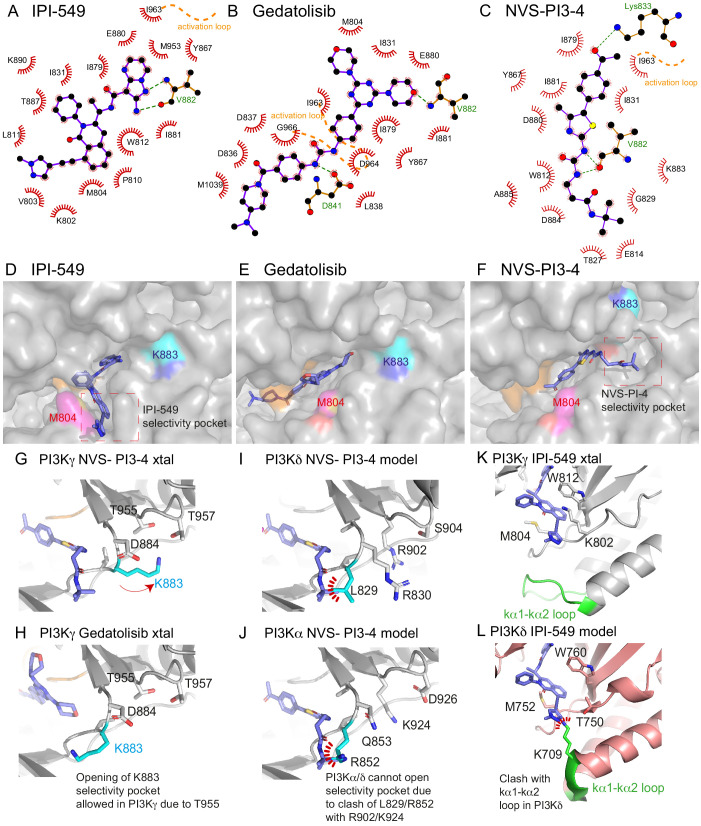
Structures of Gedatolisib, IPI-549, and NVS-PI3-4 bound to p110γ.(A–C) LigPlot+ (Laskowski and Swindells, 2011) representations of p110γ bound to (A) IPI-549, (B) Gedatolisib, and (C) NVS-PI3-4. Hydrogen bonds are shown in green. All inhibitors form hydrogen bonds (green) with V882 in the hinge. The activation loop is shown as an orange dotted line. (D–F) Comparison of Gedatolisib, IPI-549, and NVS-PI3-4 bound to p110γ with the activation loop and selectivity pockets highlighted. M804 and K883 that change conformation upon selectivity pocket opening are coloured in magenta and cyan, respectively. (G–J) Molecular basis for NVS-PI3-4 for p110γ over p110α/δ. The structure of p110γ bound to NVS-PI3-4 (G) compared to p110γ bound to Gedatolisib (H), revealed a conformational change in K883 leading to opening of pocket accommodating the t-butyl motif. Comparing this to a model of p110δ (PDB: 5DXU) (Heffron et al., 2016) (I) and p110α (PDB: 4JPS) (Furet et al., 2013) (J) with NVS-PI3-4 revealed that this pocket is unlikely to open with L829 in p110δ and R852 in p110α (corresponds to K883 in p110γ) unable to adopt this conformational change due to steric clashes / electrostatic repulsion with R902 in p110δ and K924 in p110α (corresponds to T955 in p110γ). (K–L) Molecular basis for IPI-549 specificity for p110γ over p110δ. The structure of p110γ bound to IPI-549 (H) compared to a model of IPI-549 bound to p110δ (I), based on the structure of p110δ bound to the specificity pocket inhibitor Idelalisib (PDB: 4XE0) (Somoza et al., 2015). K802 and W812 in p110γ are labelled, along with the corresponding residues in p110δ. The kα1-kα2 loop is green, with potential clashes in p110δ with the methylpyrazole of IPI-549 highlighted.